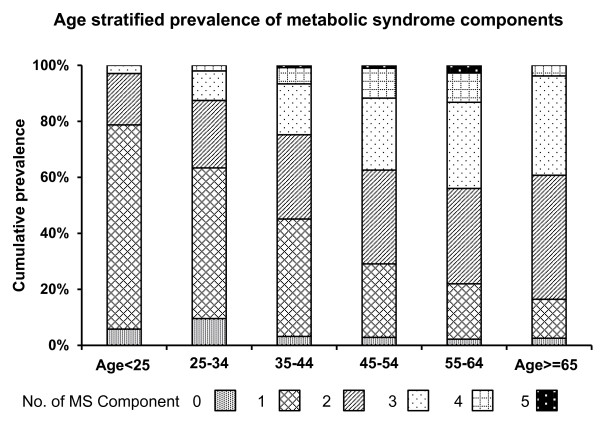
Age stratified prevalence of metabolic syndrome (MS) components of Bangladeshi rural women (NCEP ATP III criteria, n = 1535). (0 = no MS component present, 1 = one component of MS present,2 = two components MS present, 3 = three components MS present, 4 = four components MS present, 5 = five components MS present).